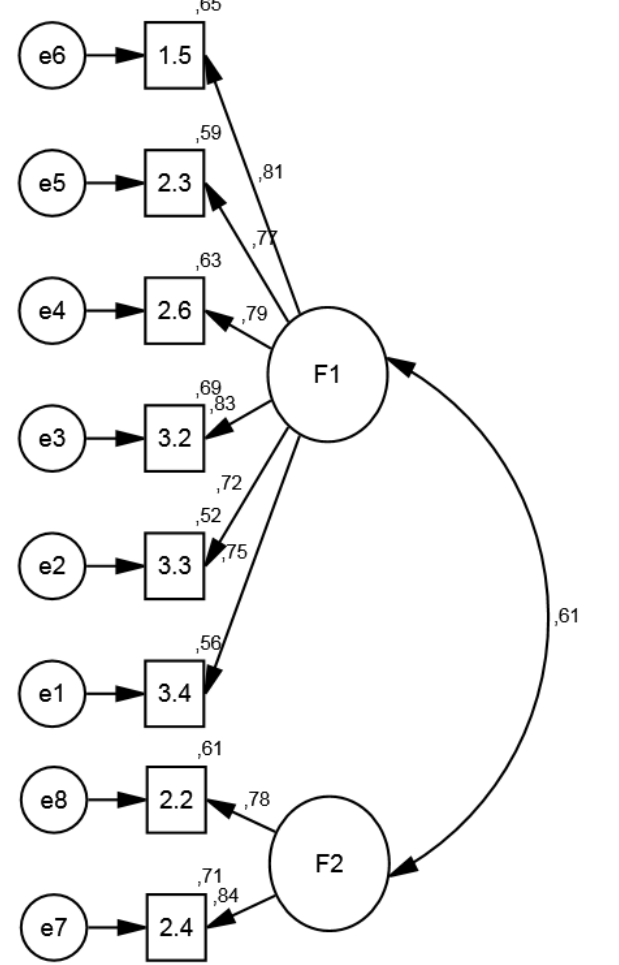
Figure 1. Multiple squared correlations and standardized regression weights. F 1 = Factor 1; F 2 = Factor 2.